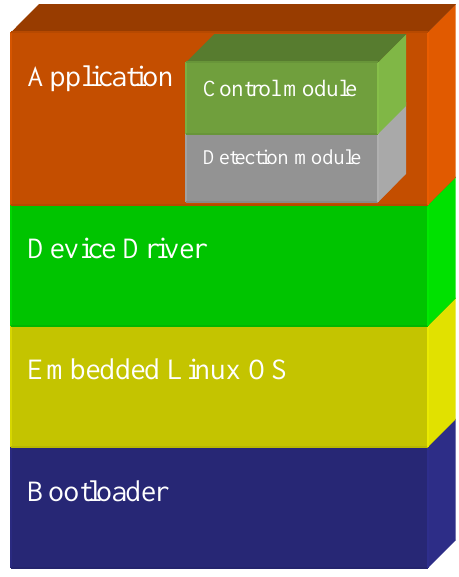
Figure 5. Software architecture of smart visual